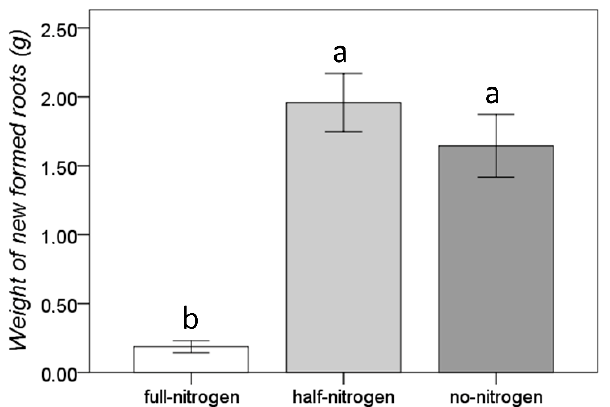
Figure 2. Effect of the short-term nitrogen deficiency on root growth. Bars represents the standard error; different letters indicate significant differences among groups resulted found by the Duncan post-hoc test.